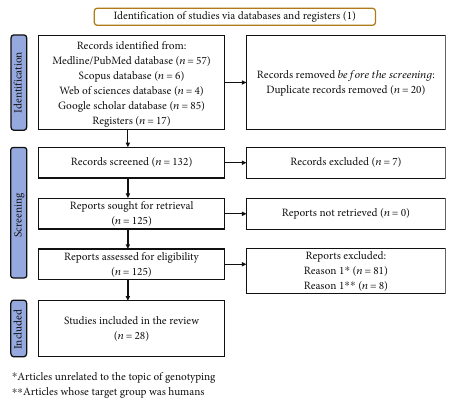
Figure 1: PRISMA fl ow diagram of the literature search and study